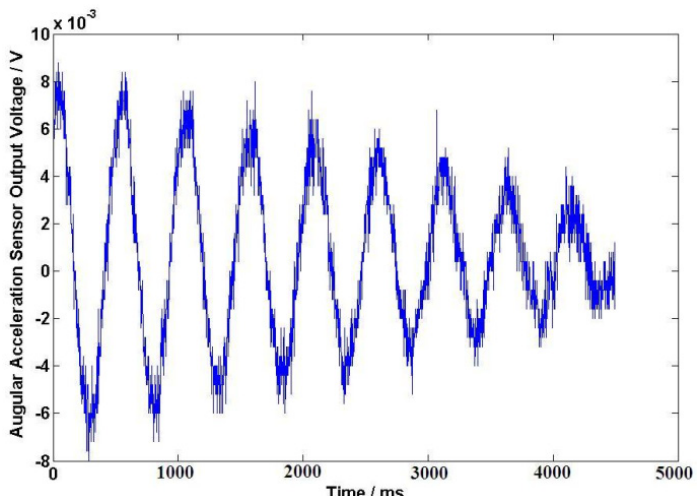
Figure 9. Output signals of angular acceleration